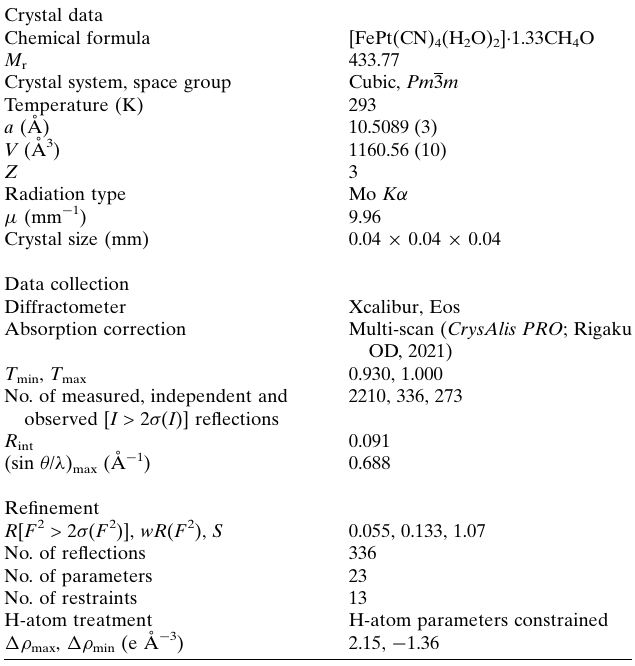
Table 2 Experimental details. Crystal data Chemical formula